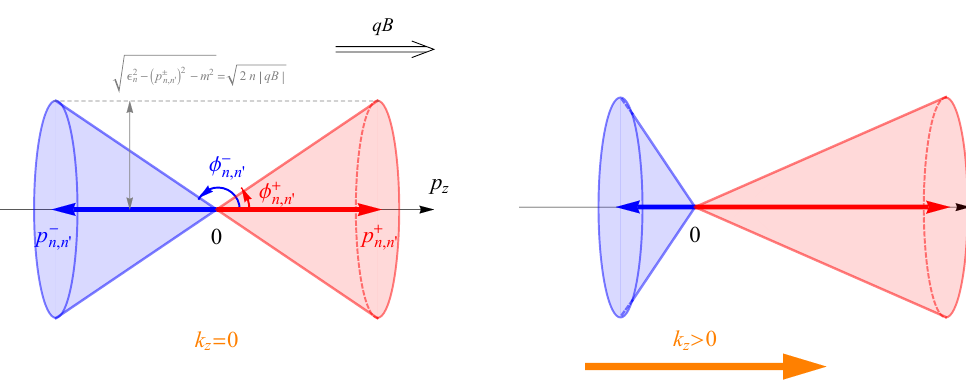
and the corresponding n,n 0 = 0 (left) and the boost effect z